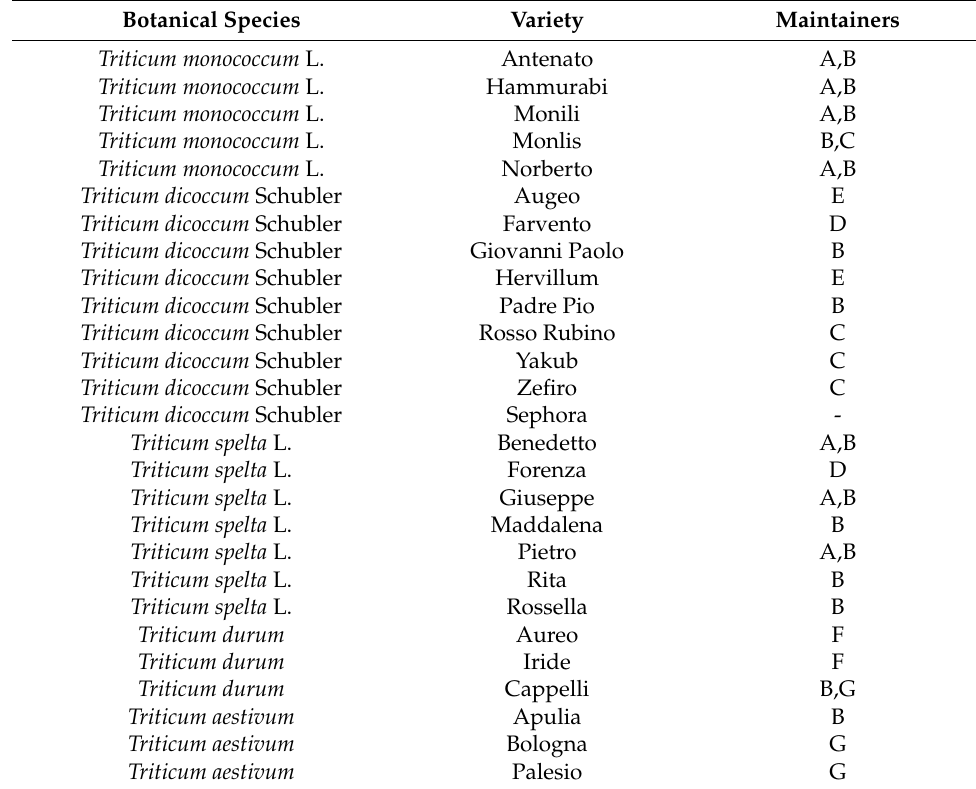
Table 2. Hulled and hulless wheat varieties used and their maintainers, defined as the natural or the legal person identified by the national seed law as responsible for maintaining the variety in purity, very often coincident with the breeder [27]. A = Fondazione M. Bolognini, Sant’Angelo Lodigiano (Lodi), Italy; B = CREA—Consiglio per la Ricerca in Agricoltura e l’Analisi dell’Economia Agraria, Italy; C = Prometeo s.r.l., Urbino (PU), Italy; D = Istituto Di Genetica Vegetale CNR, Bari, Italy; E = Agribosco s.r.l., Sigillo (PG), Italy; F = Societ à Produttori Sementi, Bologna, Italy; G = Societ à Italiana Sementi, San Lazzaro di Savena (BO),